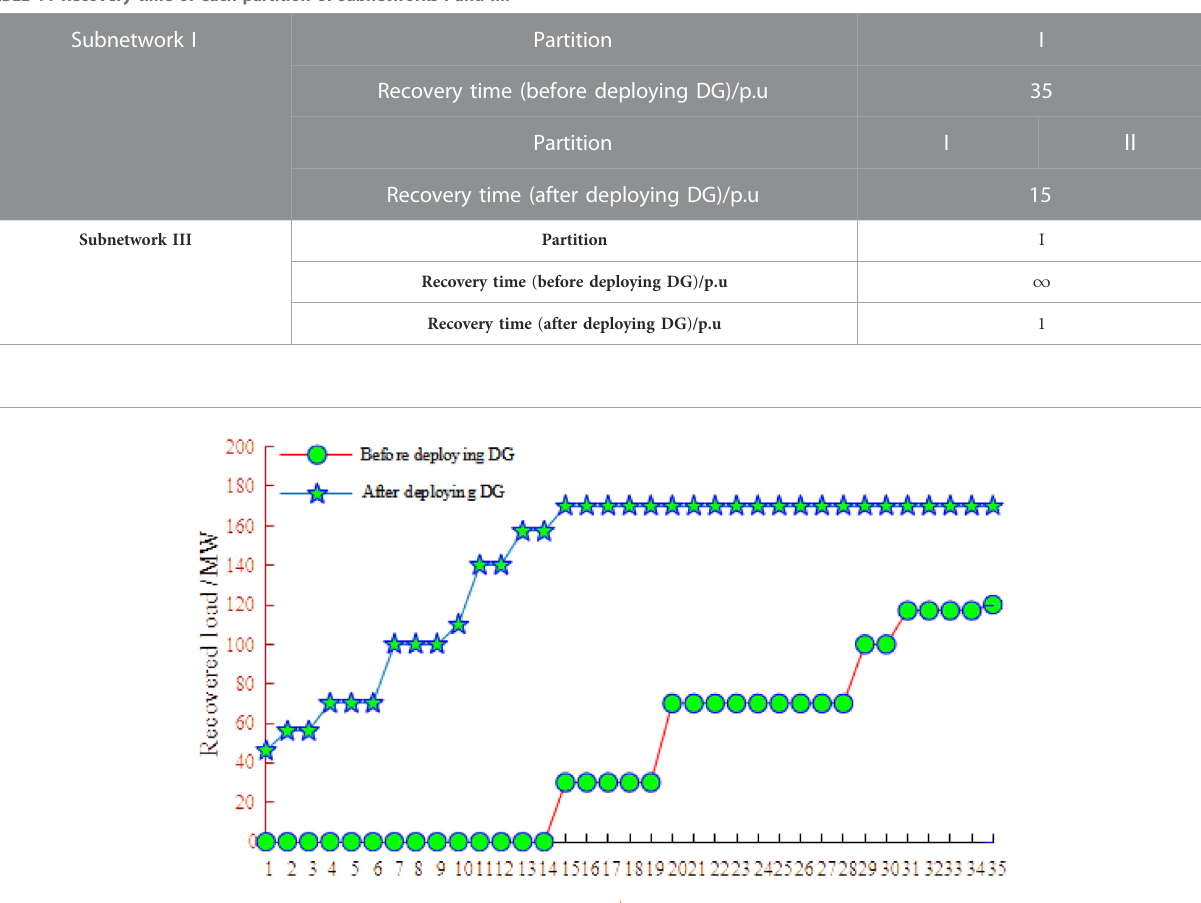
TABLE 11 Recovery time of each partition of subnetworks I and III.